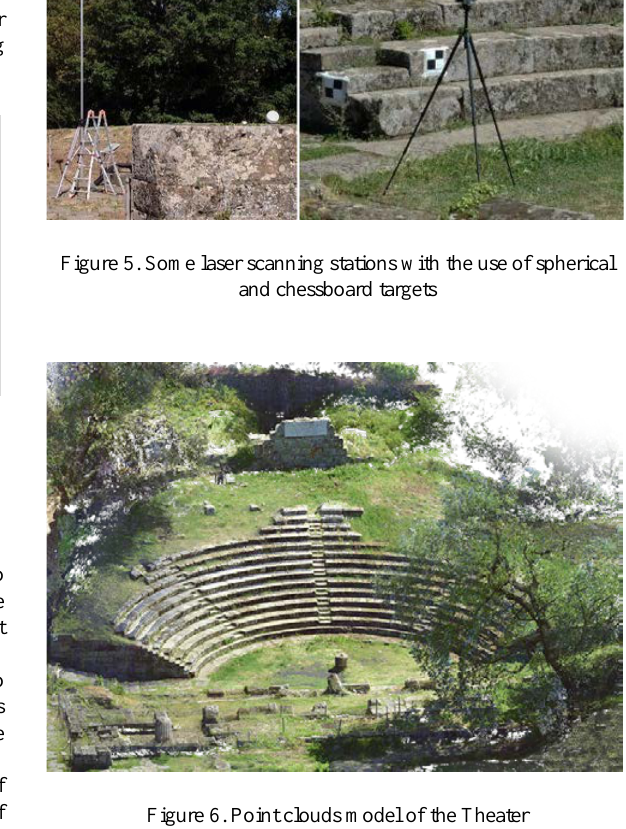
Figure 6. Point clouds model of the